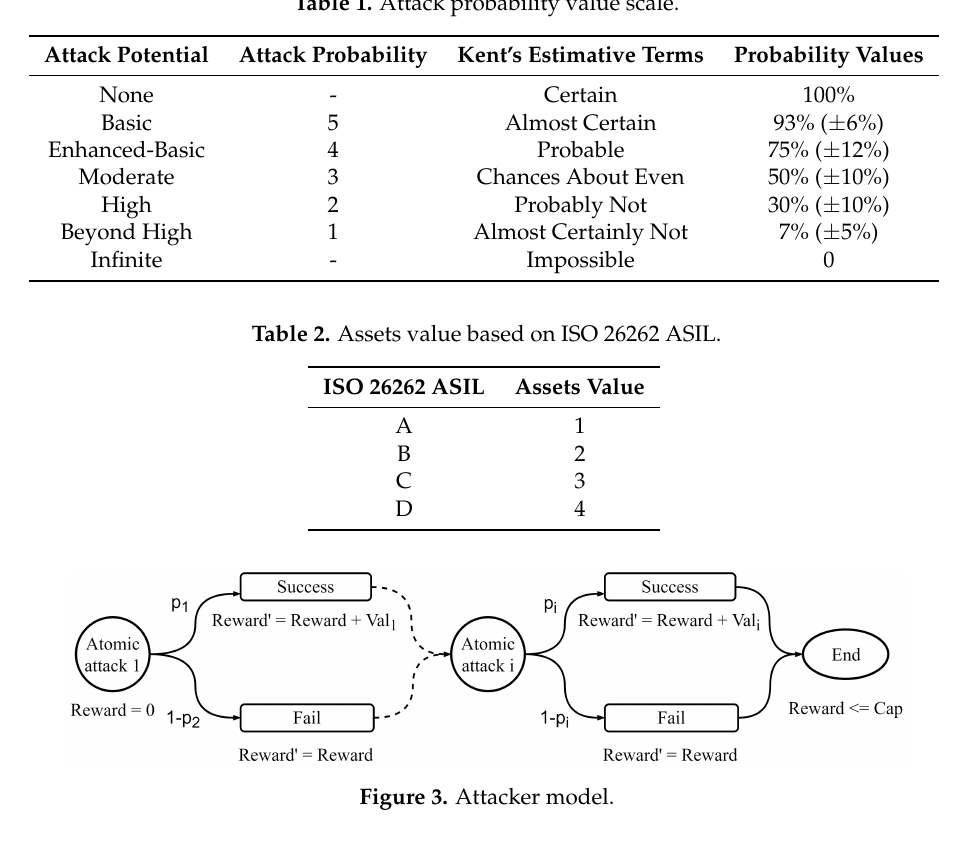
Table 1. Attack probability value scale.